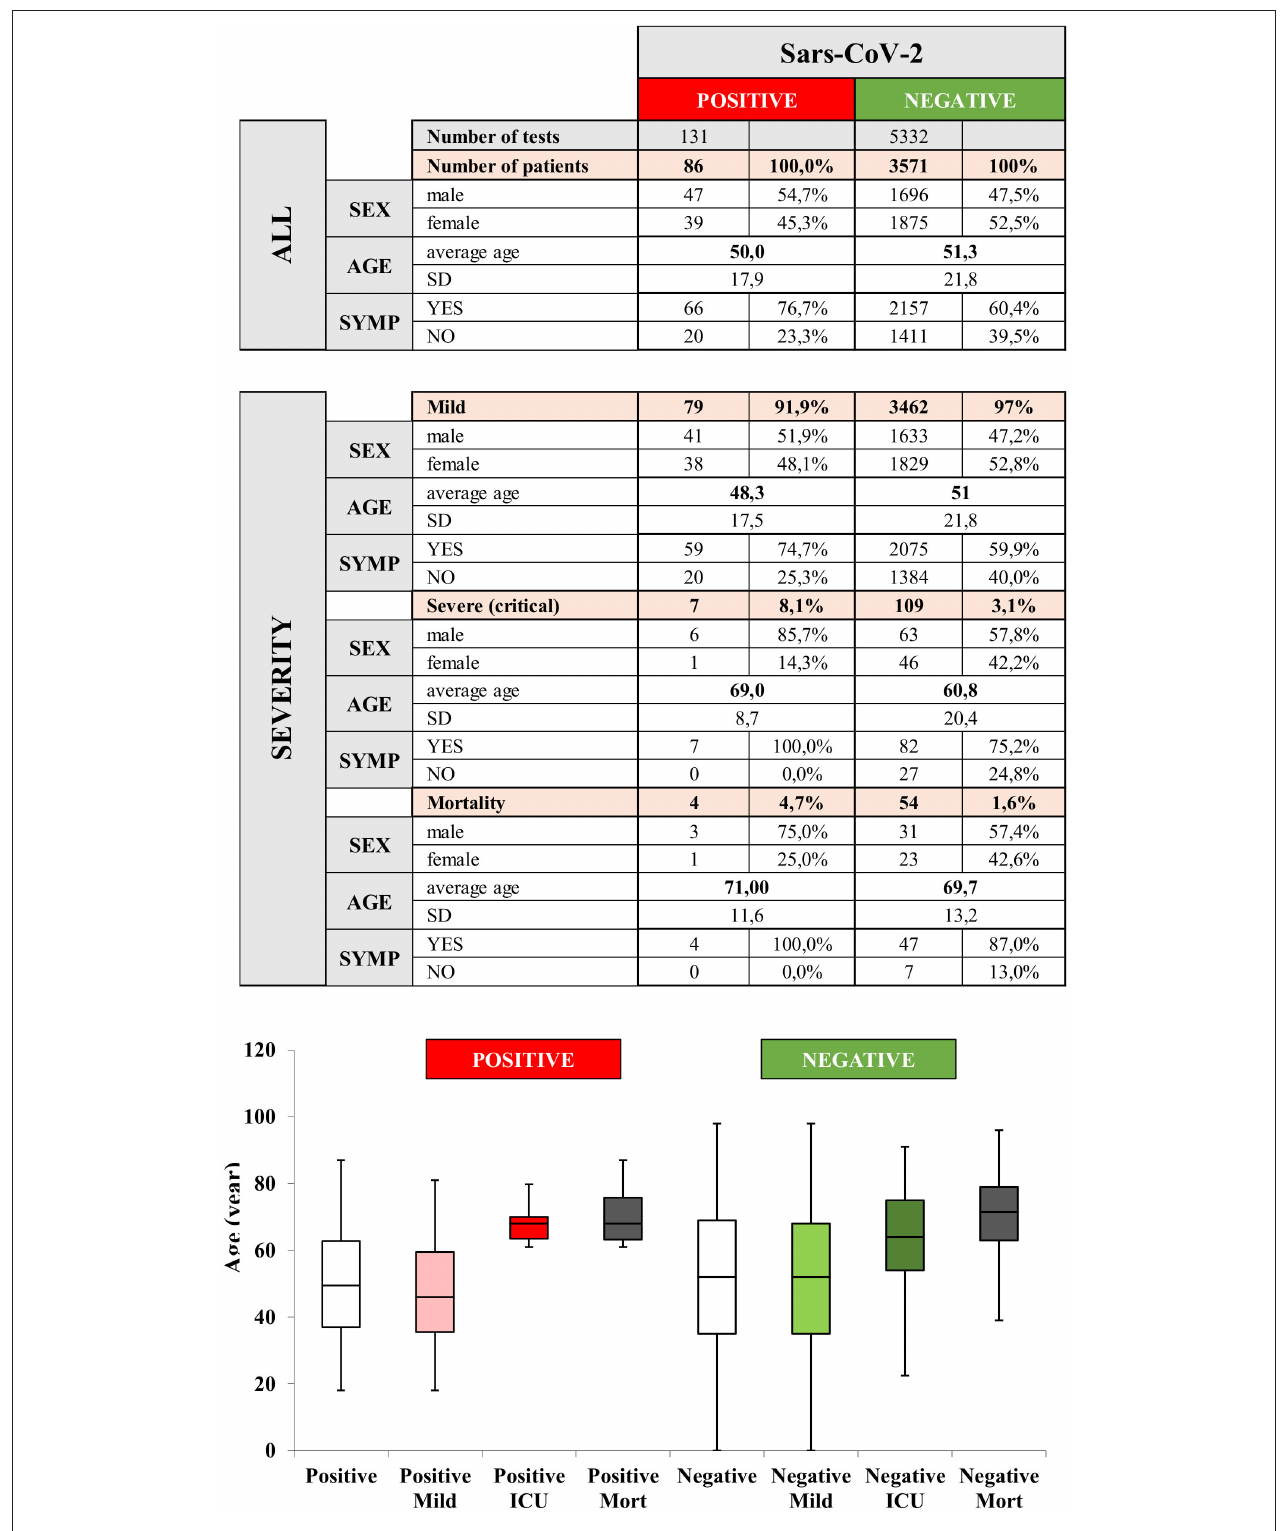
FIGURE 3 | Epidemiology and clinical outcome of the study population and comparison of negative and positive cases confirmed by polymerase chain reaction (PCR). SYMP, symptoms; SD, standard deviation; ICU, intensive care unit; Mort, mortality.